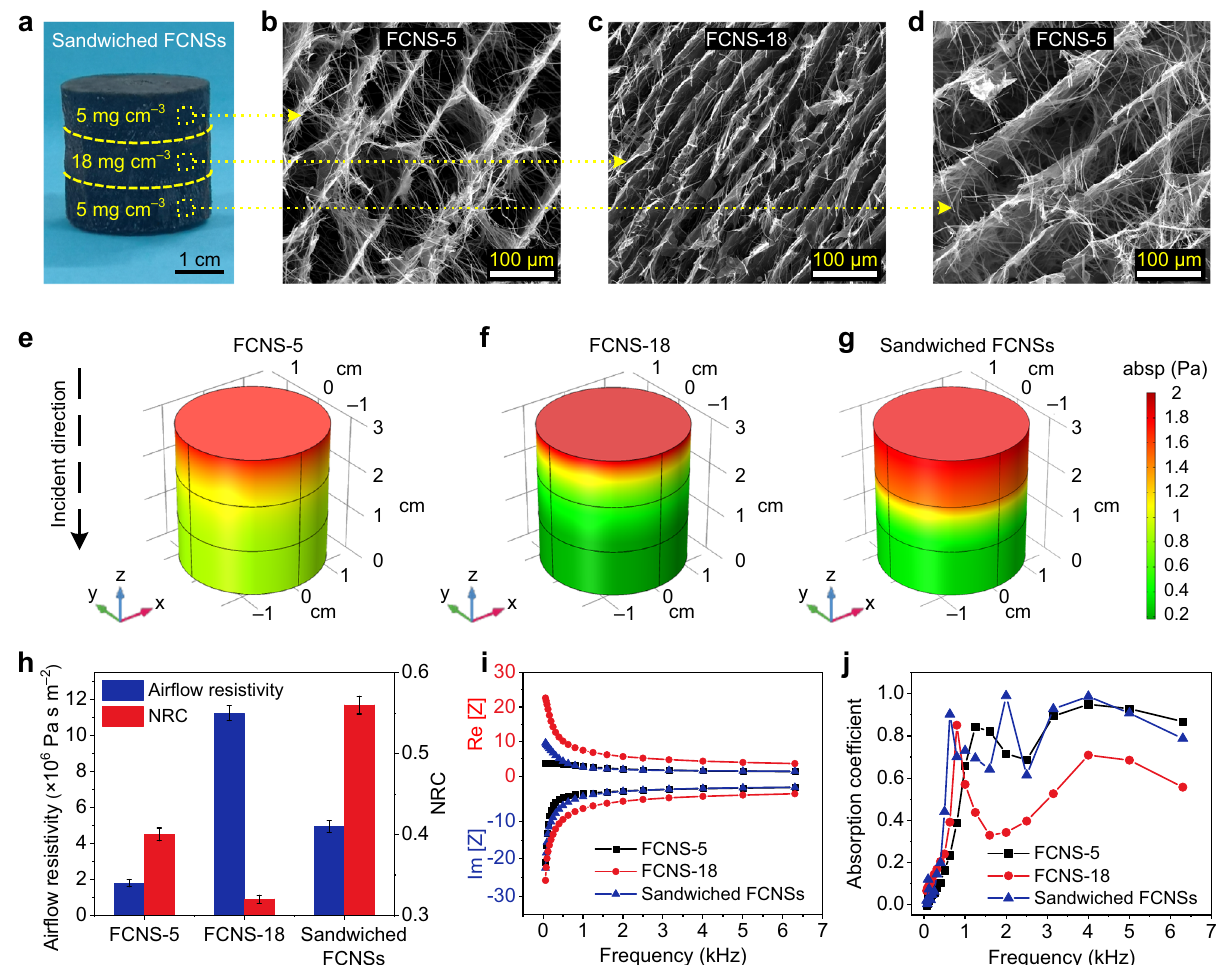
Fig. 5 Sound absorption properties of sandwiched FCNSs. a Optical and b – d SEM images of sandwiched FCNSs showing the macroscopic continuity and fl uffy – dense – fl uffy microscopic structure. Absolute sound pressure distribution of e FCNS-5, f FCNS-18, and g sandwiched FCNSs in 500 Hz. h Air fl ow resistivity and NRC of FCNS-5, FCNS-18, and sandwiched FCNSs. Error bars represent the standard deviations of three replicates. i The speci fi c